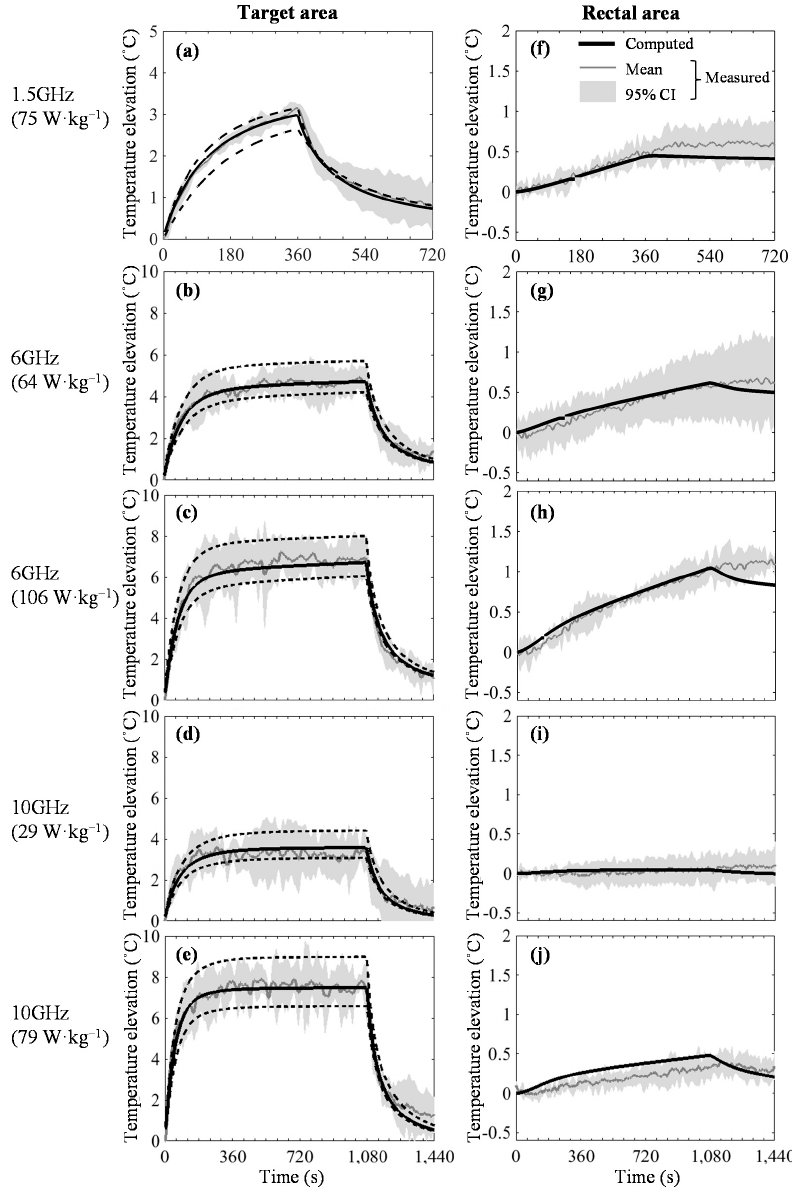
Figure 7. Temperature elevations in the target and rectal areas for each BASAR. Exposure durations correspond to: 6 min ( a , f ); and 18 min ( b – e , g – j ). The black bold line shows the temperature elevation computed in the central target area. The maximum and minimum elevations in the target area are indicated by broken lines. Temperature changes measured in the target and rectal areas of the rats are plotted for model verification ( n = 4). The gray solid line shows the average of each measured value and the gray bars show 95% confidence interval. The computed blood temperature is compared with the measured rectal temperature.